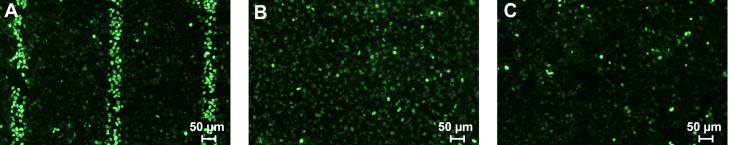
Fluorescence microscopy images using the γ-H2AX assay.DNA double-strand breaks in HeLa cells were stained after (A) microbeam irradiation and (B) homogeneous irradiation with a mean dose of 2 Gy, and (C) no irradiation. Equal acquisition, contrast, and scaling settings were applied.